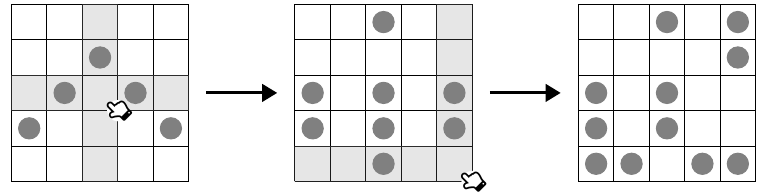
Figure 3. Example moves of a 5 × 5 two-state Alien Tiles